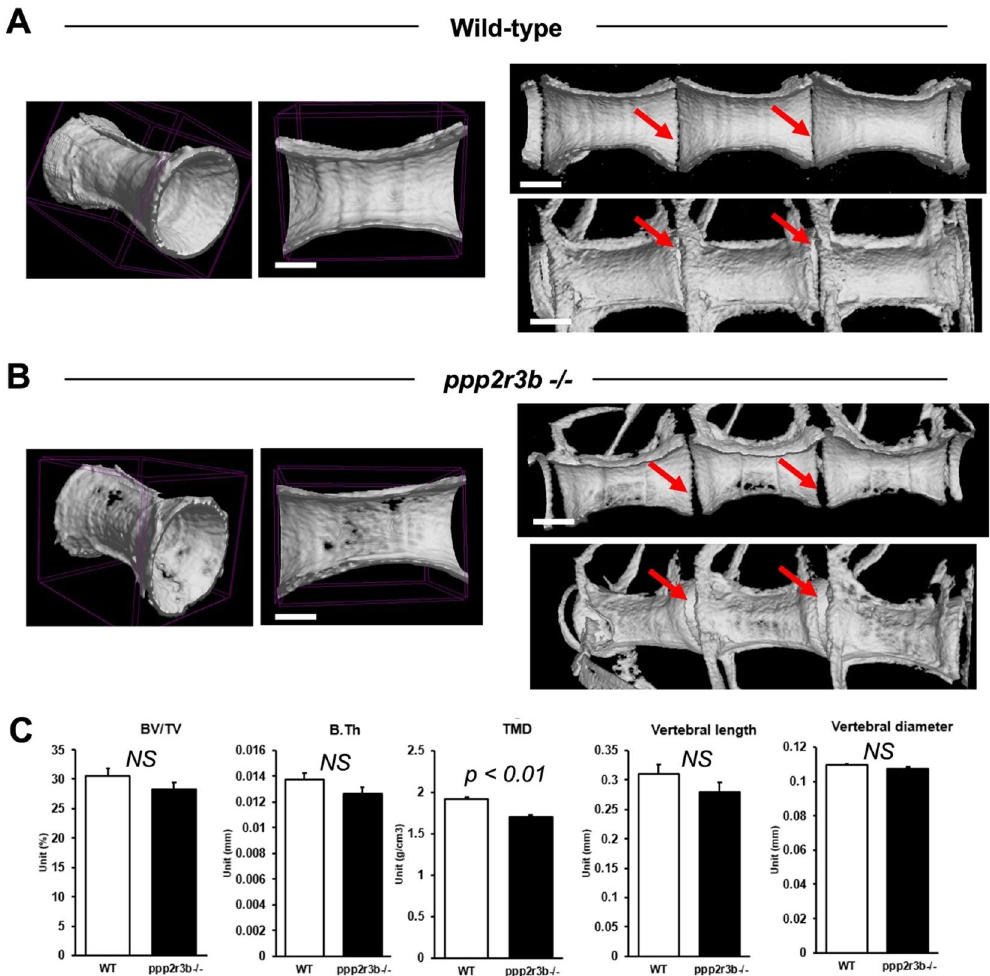
Figure 9. Reduced mineral density of vertebral cortical bone in ppp2r3b −/− mutants. ( A , B ) Representative 3D and cross-sectional images from microCT scans of vertebrae in wild-type and ppp2r3b −/− mutant zebrafish at 36 dpf. Note holes are apparent in the mutant vertebrae. Red arrows indicate intervertebral discs. ( C ) Quantification of a selection of cortical bone parameters measured in wild-type and ppp2r3b −/− mutant vertebrae ( n = 3 ). BV/TV, bone volume/tissue volume; B.Th, bone thickness; TMD, tissue mineral density. p-values are given ( t-test ). NS, not significant. Average tail length (TL) for both mutant and wild-type animals was 12.6 mm with no difference between the two groups ( p- value = 0.15, t-test ). TLs of the two representative animals shown in ( A ) and ( B ) were 12.912 and 12.907 mm, respectively. Animals are generation F4. Scale bars are 5 mm in ( A , B ) left panel; 3.75 mm ( A , B ) right